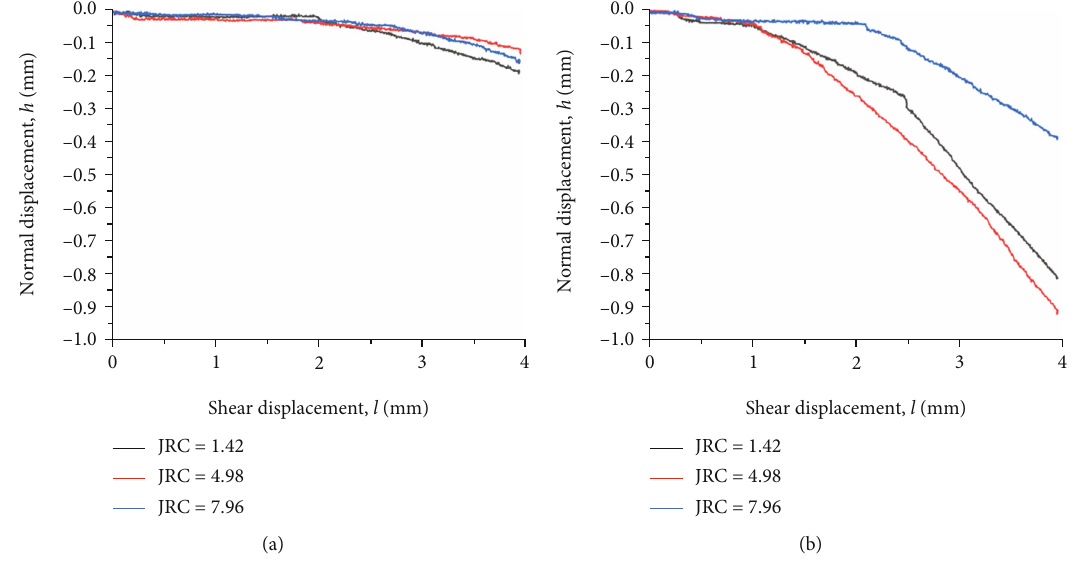
Figure 12: Shear-normal displacement curves at two normal stresses: (a) 15 MPa; (b) 30 MPa.